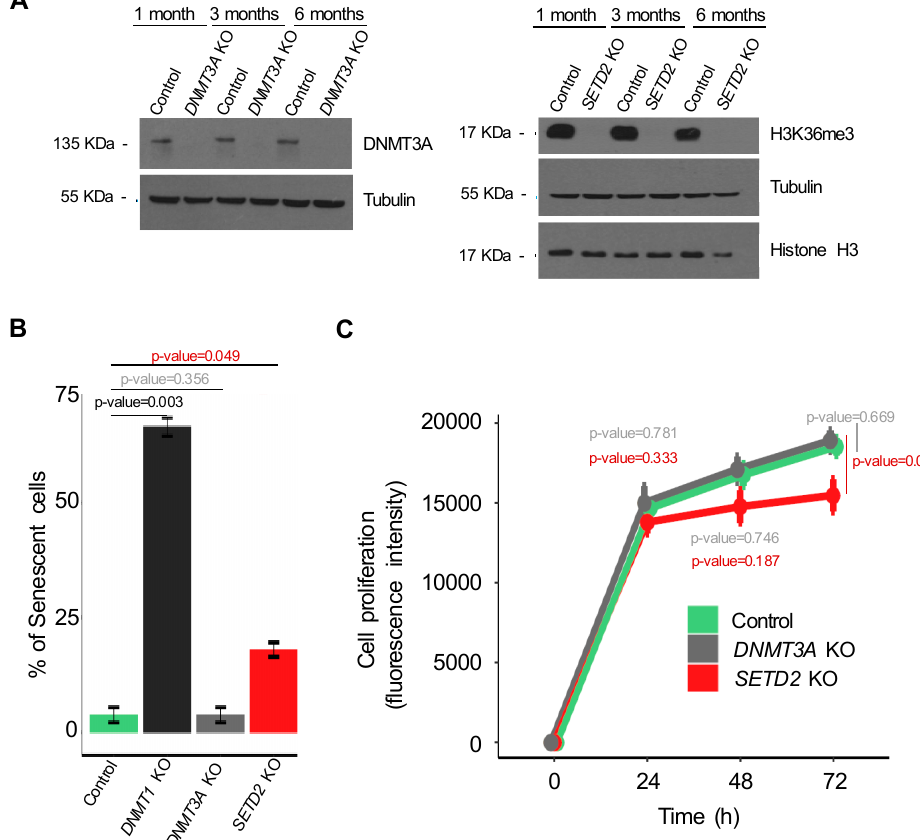
Figure 3. CRISPR/Cas9 knockout of candidate ITH-driver genes in cancer cells. ( A ) The levels of DNMT3A and H3K36me3 were estimated by western blot 1, 3 and 6 months after knockout. ( B ) The percentage of senescent cells in control and mutant conditions ( SETD2, DNMT1 and DNMT3A knockouts) was assessed by β -galactosidase staining (error bars indicate SEM; n = 3 counting regions of 150 cells/condition in triplicate; Student t -test). ( C ) The proliferation rate of the indicated cells was measured by AlamarBlue dye reduction at the indicated time points. All data are presented as mean (four technical replicates in the same experiment) ± SEM.